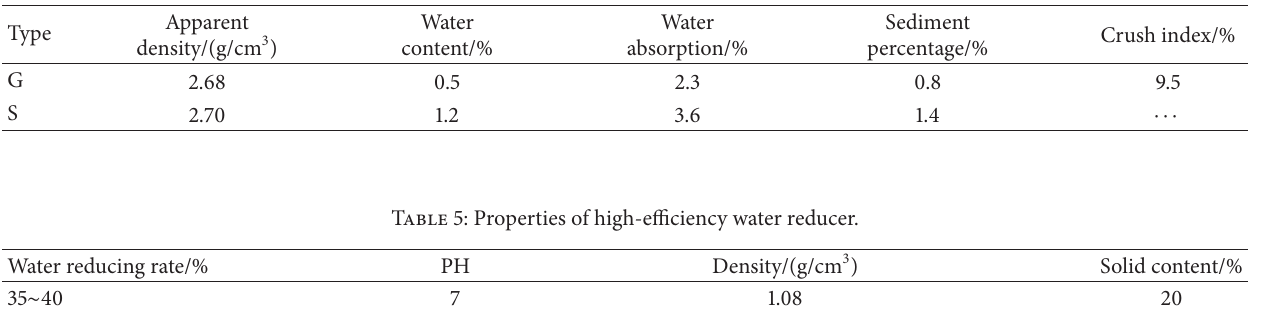
Table 4: Physical properties of the aggregates.